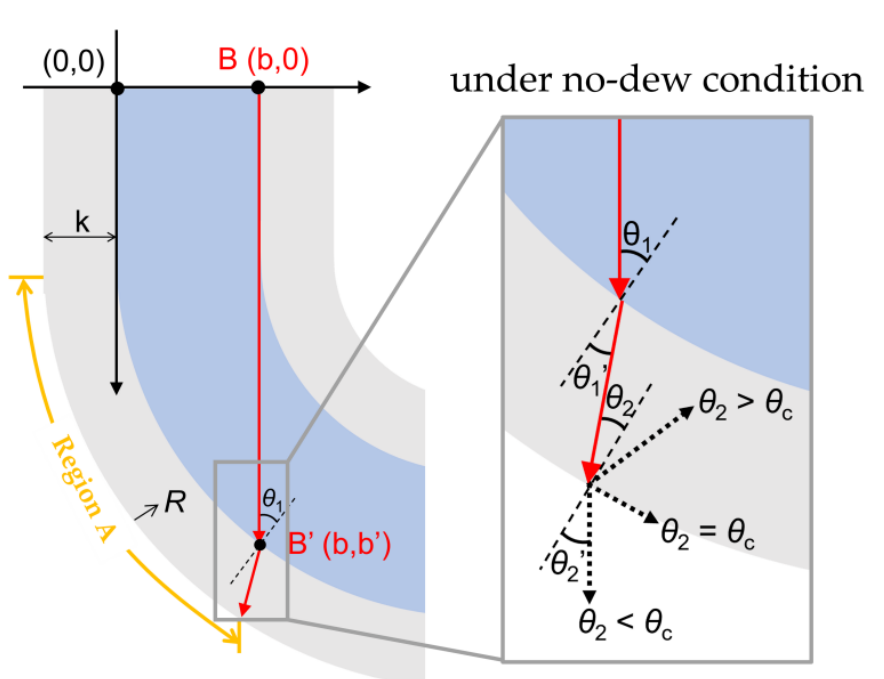
Figure 2. The geometry of the waveguide with curvature and the design strategy in which the condition of the total reflection at the external interface is considered.